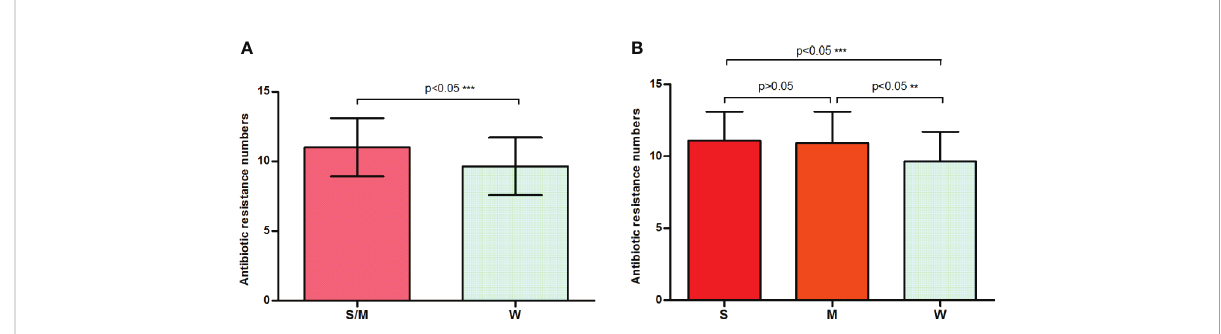
TABLE 2 The relationship among bio fi lm-forming ability of E. anophelis with antibiotic resistance pattern. Bio fi lm formation ability Strong (n = 80) Moderate (n = 82) Weak (n = 35) Antibiotics